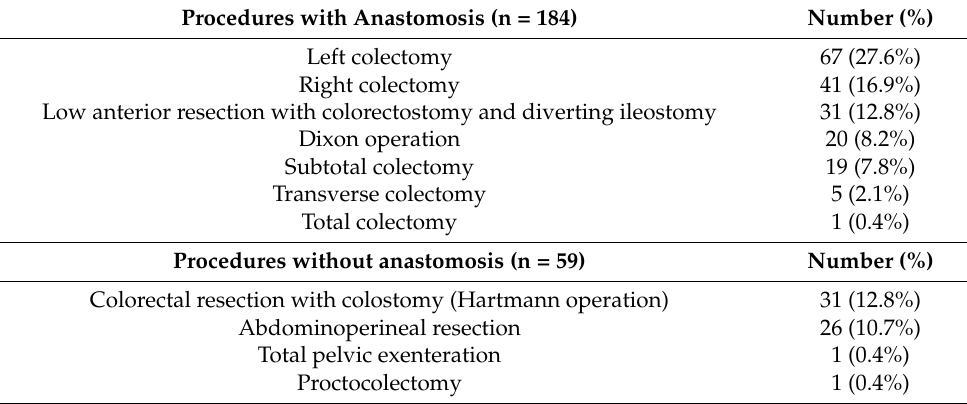
Table 1. List of detailed procedures for the colorectal tumors. Procedures with Anastomosis (n = 184) Number (%) Left colectomy 67 (27.6%) Right colectomy 41 (16.9%) Low anterior resection with colorectostomy and diverting ileostomy 31 (12.8%) Dixon operation Subtotal colectomy Transverse colectomy 5 (2.1%) Total colectomy 1 (0.4%) Procedures without anastomosis (n = 59) Number (%) Colorectal resection with colostomy (Hartmann operation) 31